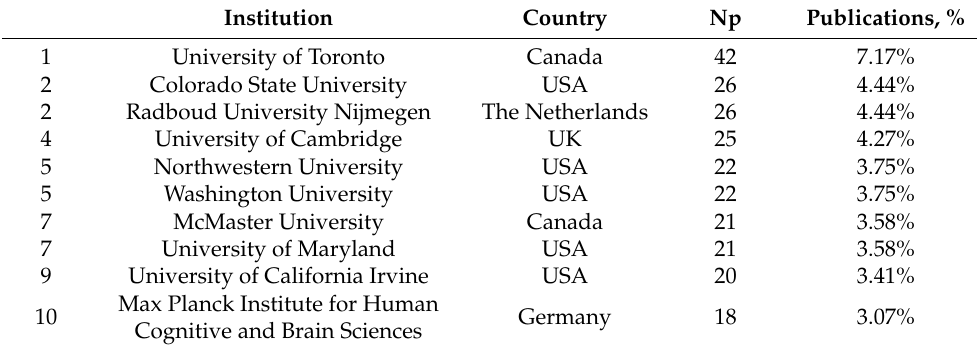
Table 2. The top 10 institutions of origin of rhythmic auditory stimulation research.